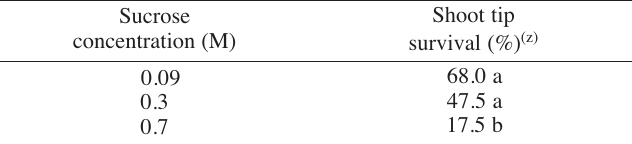
at P ≤ 0.05 by the post hoc Multiple Comparison test. Table 4 - Shoot tip survival percentage of three selected red chicory lines, following incubation and immersion in LN test.Shoot Red Chicory Line Loading time with PVS2 (min)